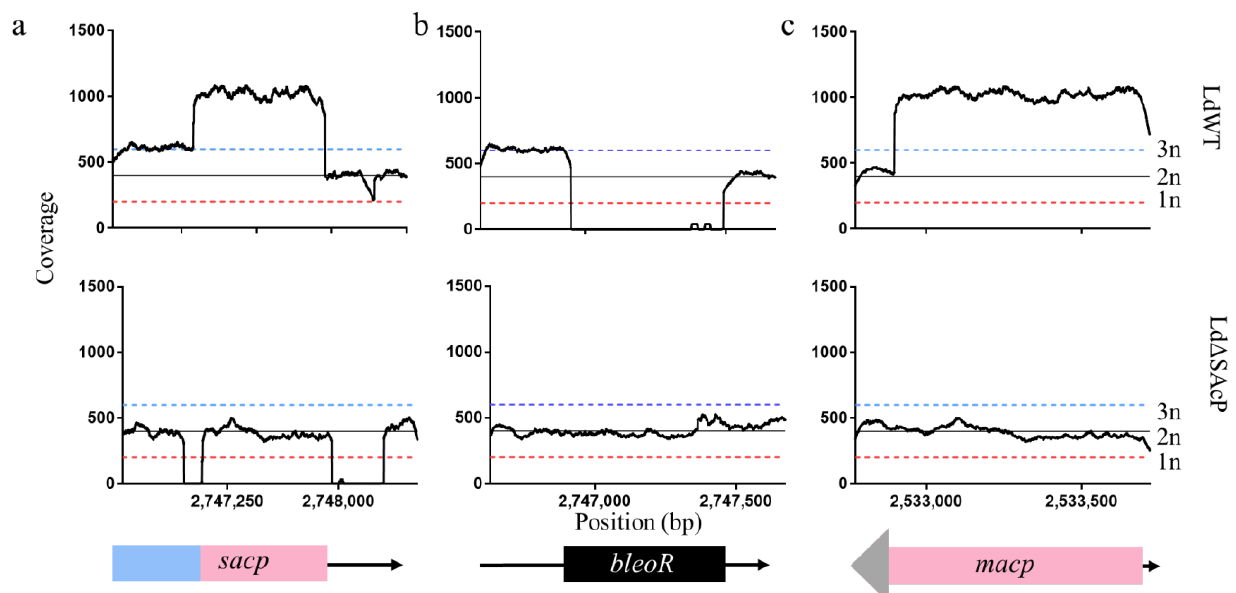
Figure 4. Whole-genome sequencing shows specificity of CRISPR-Cas9 gene knockout. Read depth coverage by base pair was determined using the module bedtools coverage over three separate reference files illustrated at the bottom of the figure. ( a ) The L. donovani 1S2D wild type genome (top) and the mutant genome (middle) are aligned to the wild type sacp gene (bottom). The sacp gene is blue with pink demonstrating the region with genomic similarities between the macp gene and the sacp gene from 2,747,080 to 2,747,953, which has a coverage of ~1000× in LdWT. Positions 2,748,288 – 2,748,310 and 2,746,950 – 2,746,972 are the positions of the gRNAs used to target the sacp gene and both positions have an average coverage of 0 in LdΔSAcP. ( b ) The L. donovani wild type genome (top) and the mutant genome (middle) are aligned to the bleoR gene (black), which was inserted into the sacp gene (bottom). LdWT has an average coverage of 0 over the bleoR gene whereas LdΔSAcP has continuous coverage. ( c ) The L. donovani wild type genome (top) and mutant genome (middle) are aligned to the macp reference genome, which is pink (bottom). LdWT has an average coverage ~1000× where the macp gene and the sacp gene are nearly identical, which drops to ~400× in the LdΔSAcP genome. The red dotted line represents the expected coverage for 1n, the solid black line represents the expected coverage for 2n and the blue dotted line represents the expected coverage for 3n.